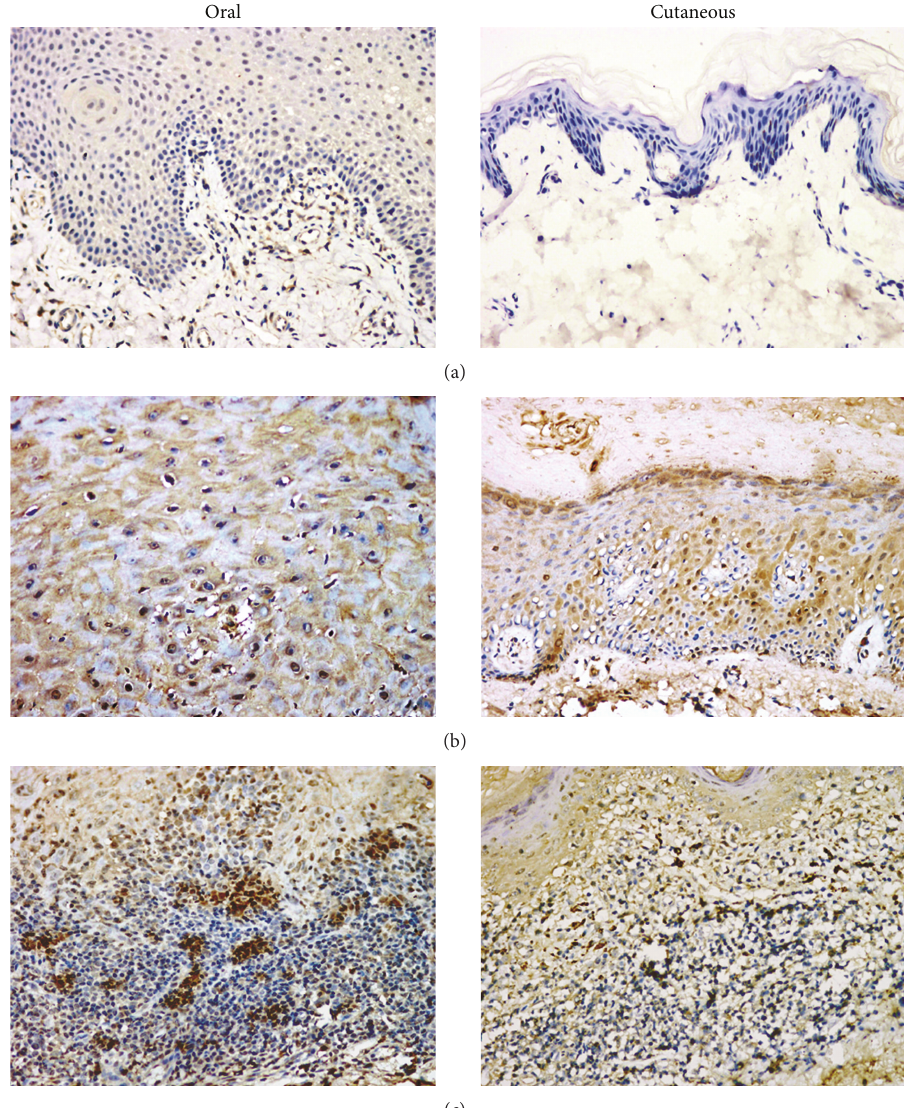
Figure 2: Representative expression pattern of IL-23: (a) negativity in normal oral mucosa and skin; (b) positivity in epithelial cells of oral and cutaneous lichen planus (LP); (c) positivity in subepithelial cells of oral and cutaneous LP. Magnification, ×